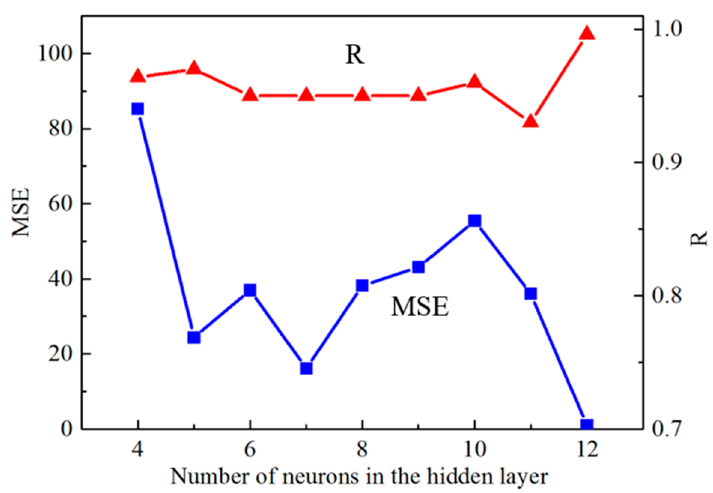
Figure 7. The values of R and MSE for the different ANN models.